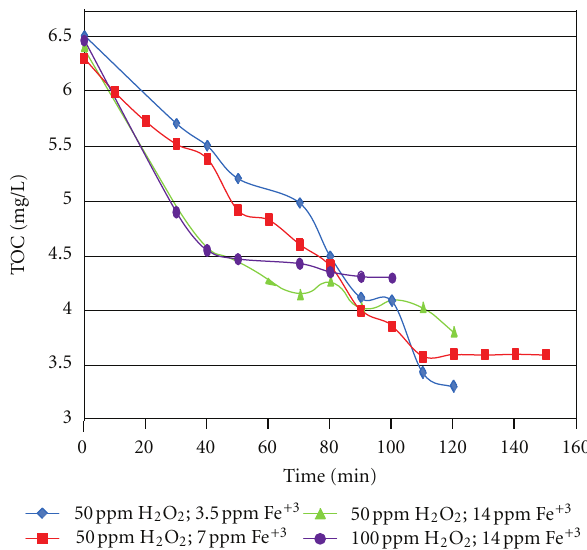
Figure 9: Homogeneous photocatalysis of mepiquat chloride using the photo-Fenton agent (initial conditions: 10ppm mepiquat chloride, UV-A lamp).